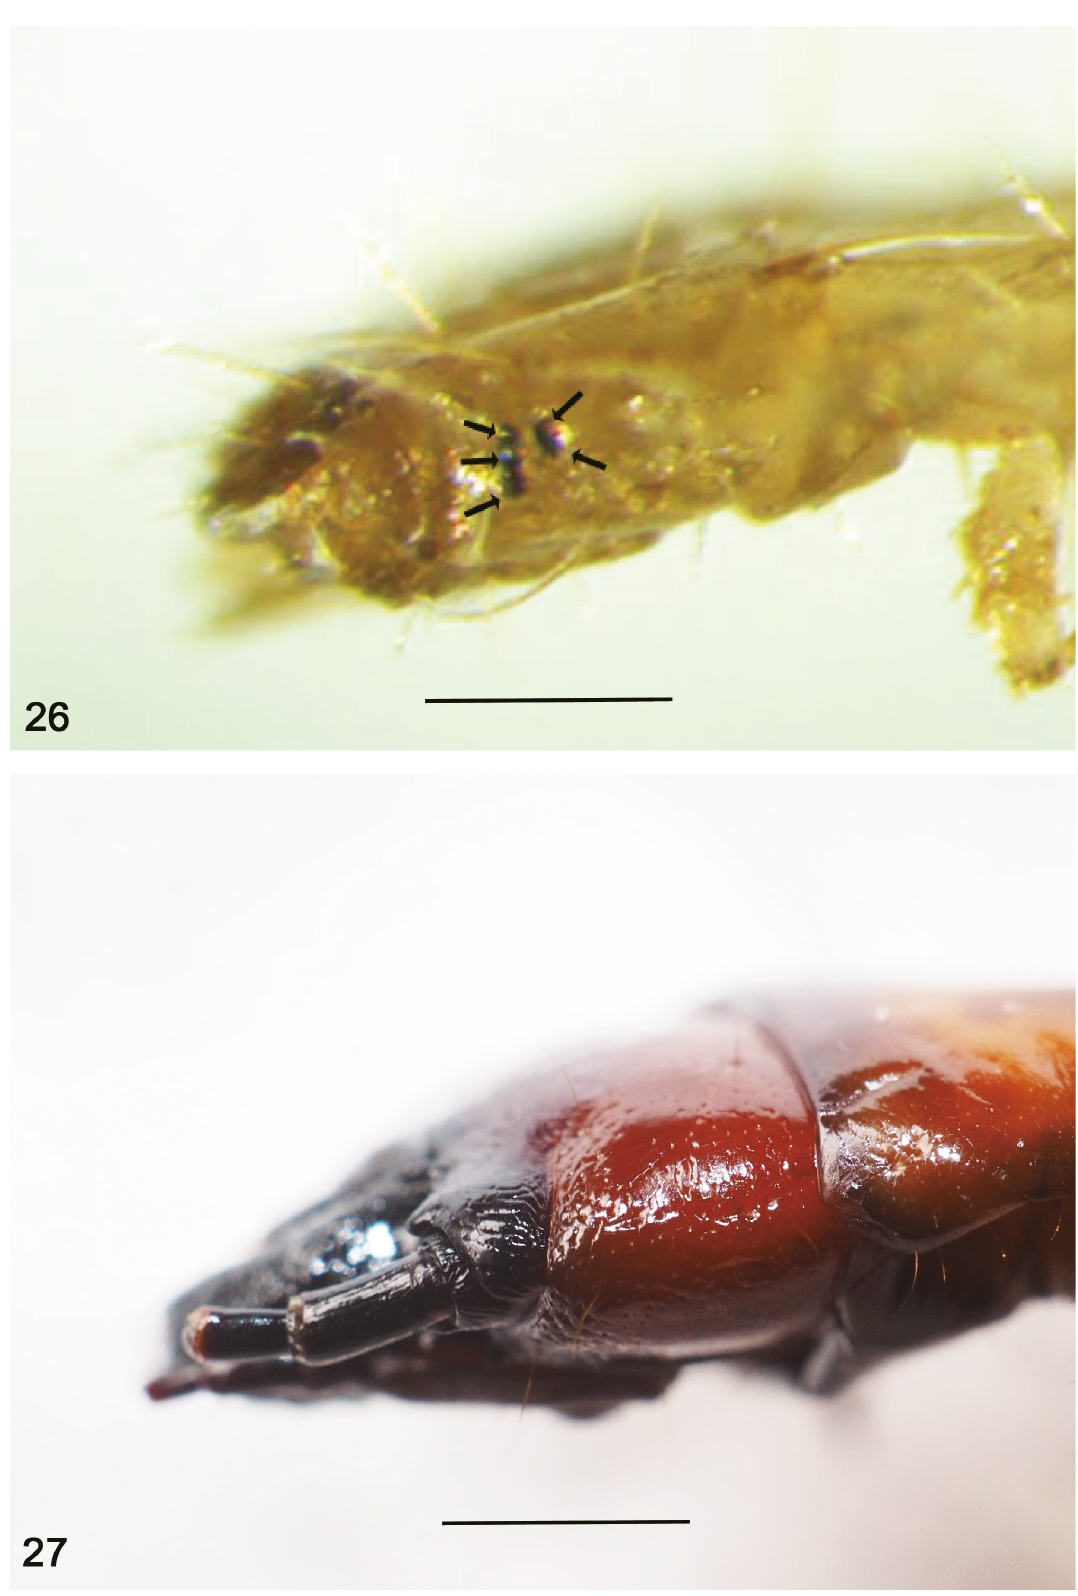
Figs 26–27. Head of larva of Trictenotoma formosana Kriesche, 1919 in lateral view. 26 . First-instar larva; arrows indicate the 5 stemmata. 27 . Last-instar larva. Scale bars: 26 = 0.1 mm; 27 =